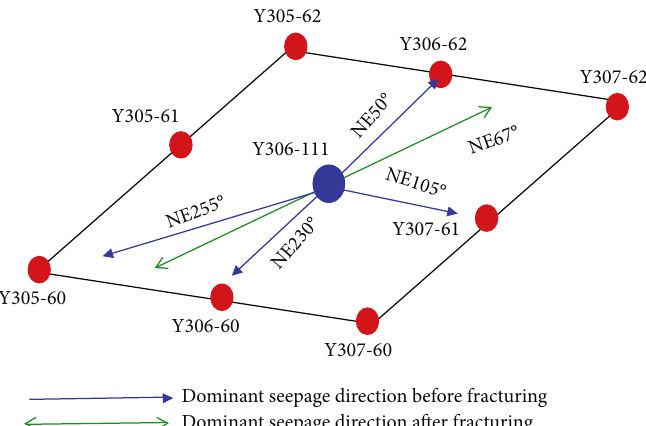
Figure 10: Schematic diagram of dominant seepage direction of water drive before and after fracturing of well cluster Y